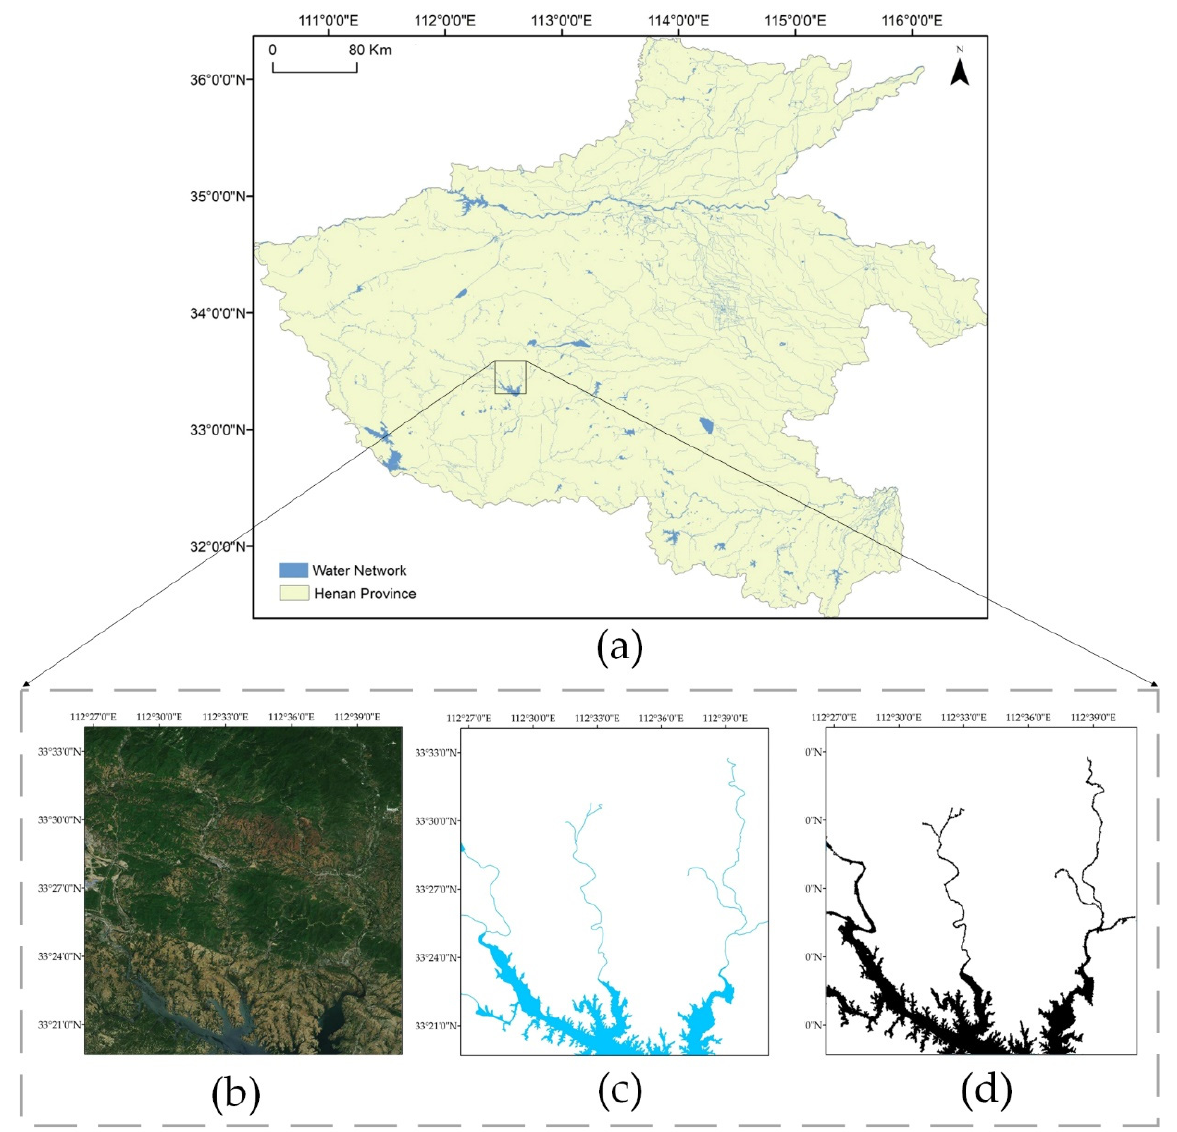
Figure 16. Extraction results and corresponding optimal image ( a ) water stream of Henan Province, ( b ) Landsat-8 optical image, ( c ) water stream of partial enlarged drawing of ( a ), and ( d ) ground truth.